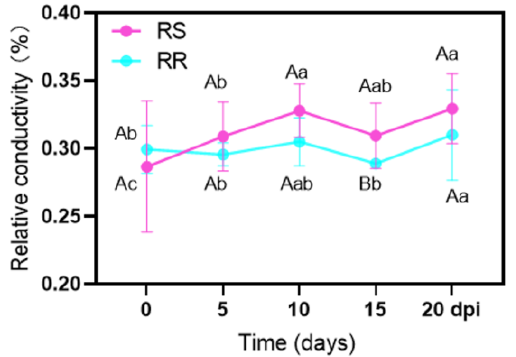
Figure 6. Changes in electrolyte leakage in rust-resistant Z. japonica (RR) and rust-susceptible Z. japonica (RS) after inoculation with P. zoysiae . Different lowercase letters mean significant difference among different days in the same material at p < 0.05. Different capital letters indicate significant difference between the two materials at a given date at p < 0.05.